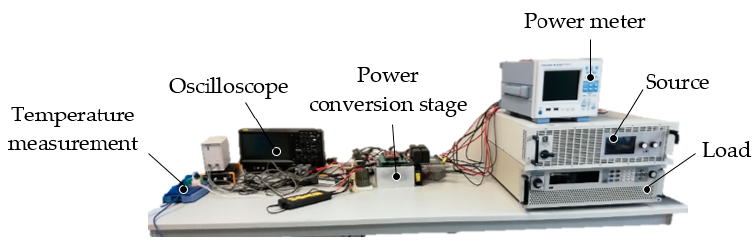
Figure 11. The setup for the experimental tests.